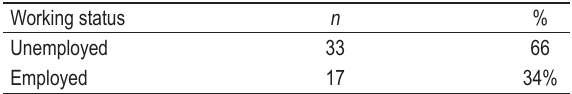
TABLE 3. Working status of the respondents